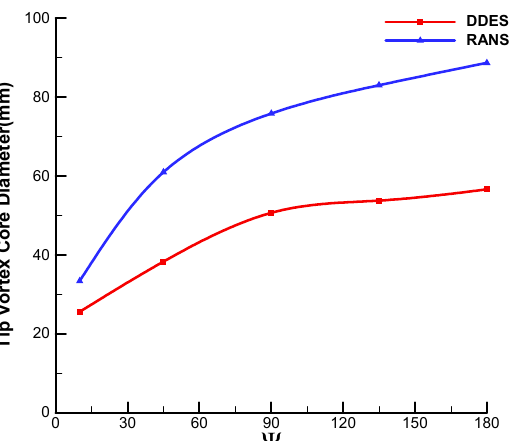
Figure 17. Comparisons of velocity profiles at comparable wake ages.